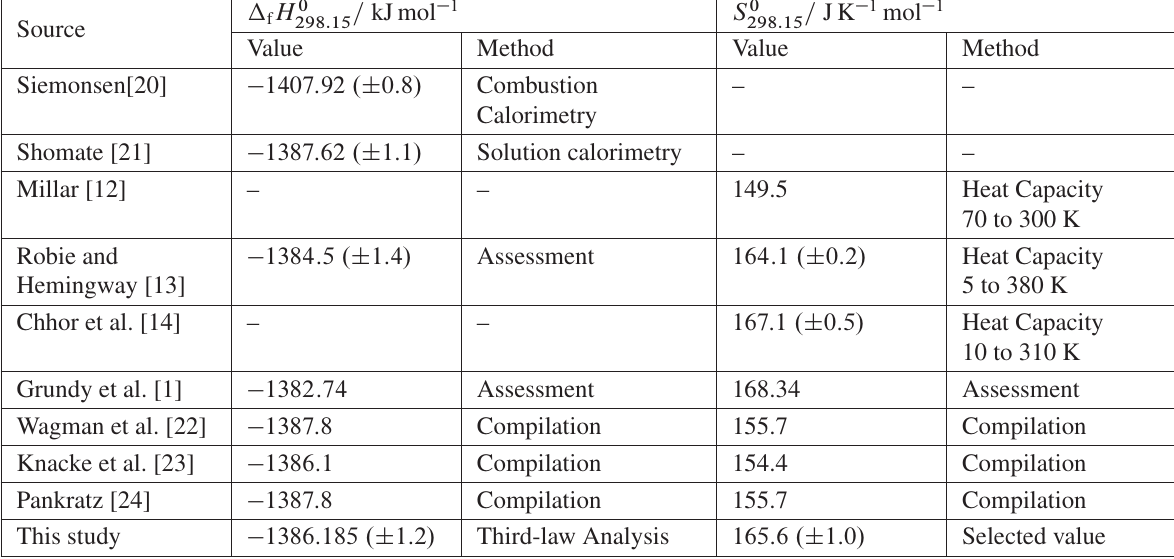
Table 3. Comparison of basic thermodynamic data for Mn 3 O 4 selected in this study with values reported in the literature. value of (cid:4) 441:4. ˙ 5:8/ kJ mol (cid:3) 1 for reaction (12)